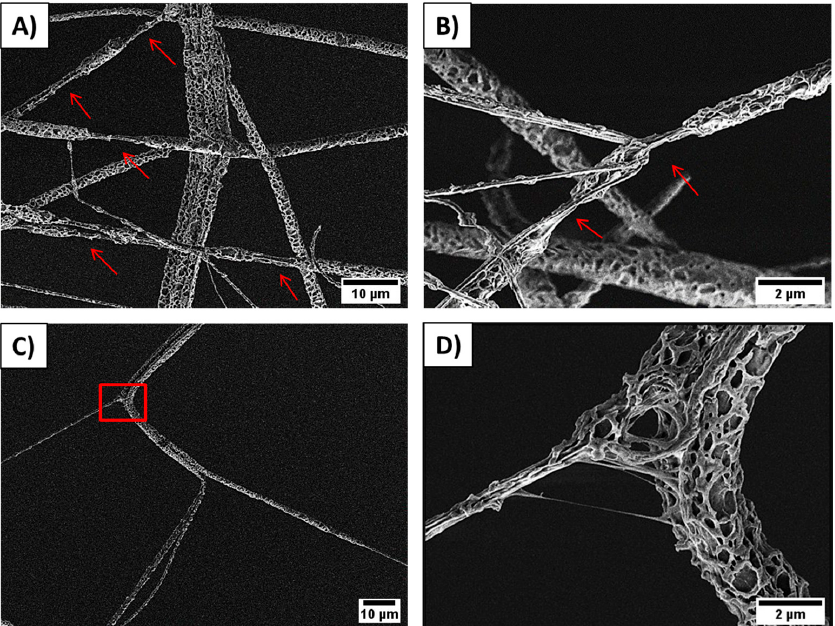
Figure 4. SEM images showing pPCL random fibers stretching and the formed interlocking systems between pores: ( A ) fiber necking formed after fiber interlocking, ( B ) overlapped pPCL fibers forming necking areas marked with arrows, ( C ) individ- ual fibrils in pPCL fiber stick together and stretched, and ( D ) zoom in to the square marked in the previous image, showing the interaction between two connected fibers during the tensile testing, see also Movie S2 in the Supplementary